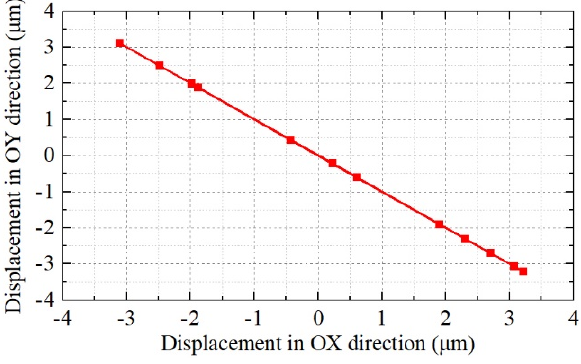
Figure 5. The calculated driving trajectory.